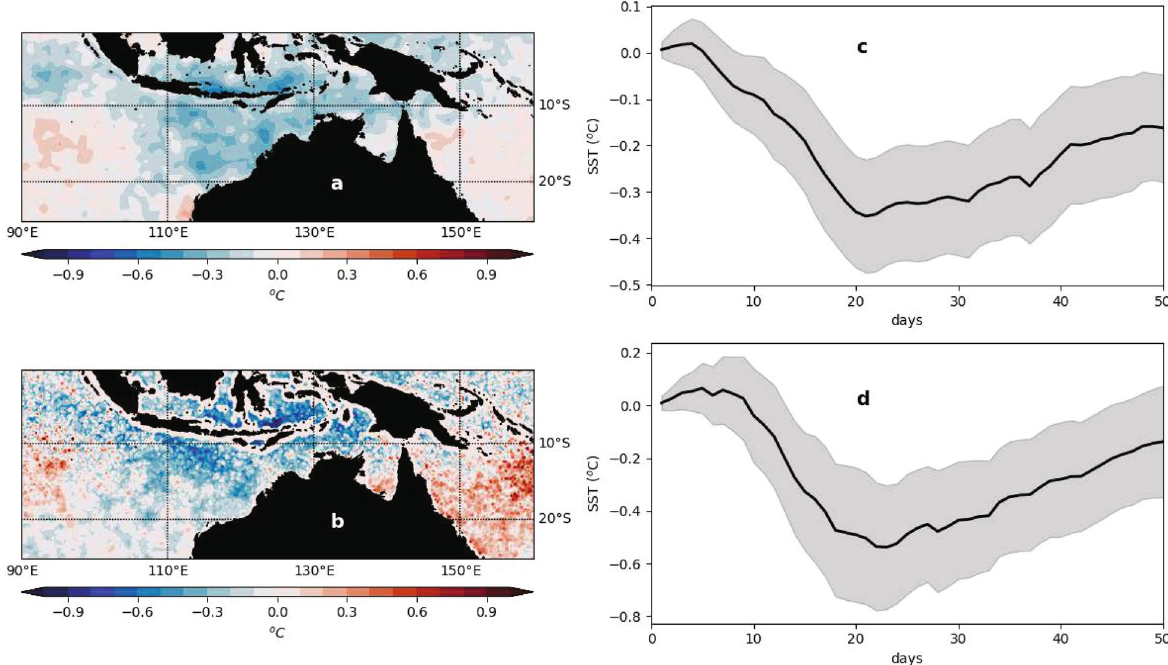
Fig. 1 SST response to MJO-forcing over the MC. a Composite mean upper-ocean response to the MJO based on NOAA OI SST (°C) for the period 1982 – 2019. The composite is generated from 91 MJO events over the 38-year period. b Composite mean upper-ocean response to the MJO based on TRMM SST (°C) for the period 1998 – 2014. The composite is generated from 41 MJO events over the 17-year period. c Composite mean time evolution of SST (°C), based on NOAA OI SST and MJO events identi fi ed in ( a ). d Composite mean time evolution of SST (°C), based on TRMM SST and MJO events identi fi ed in ( b ). In panels ( c , d ), the SST is averaged over the region 110°E – 130°E and 15°S – 5°S, and the gray shading represents the 95% con fi dence intervals computed as 1.96 times the standard